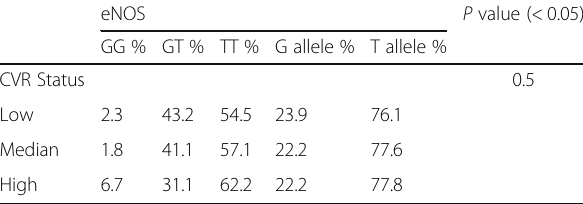
Table 2 G894 T eNOS distribution Vs Cardio Vascular Risk eNOS P value (< 0.05)